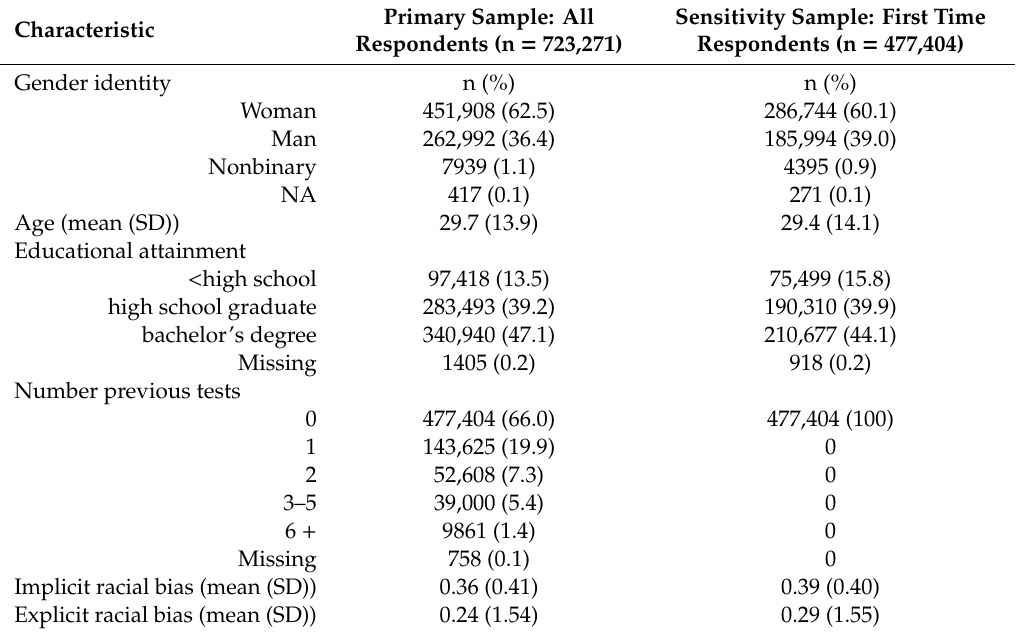
Table A7. Characteristics of IAT test-takers by previous tests,